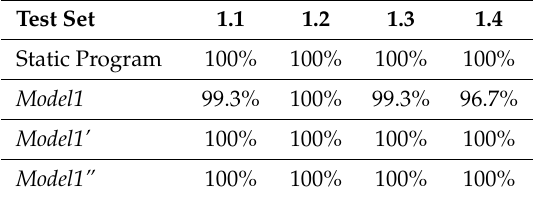
Table 2. Classification accuracies of the static program and the models on three colours.